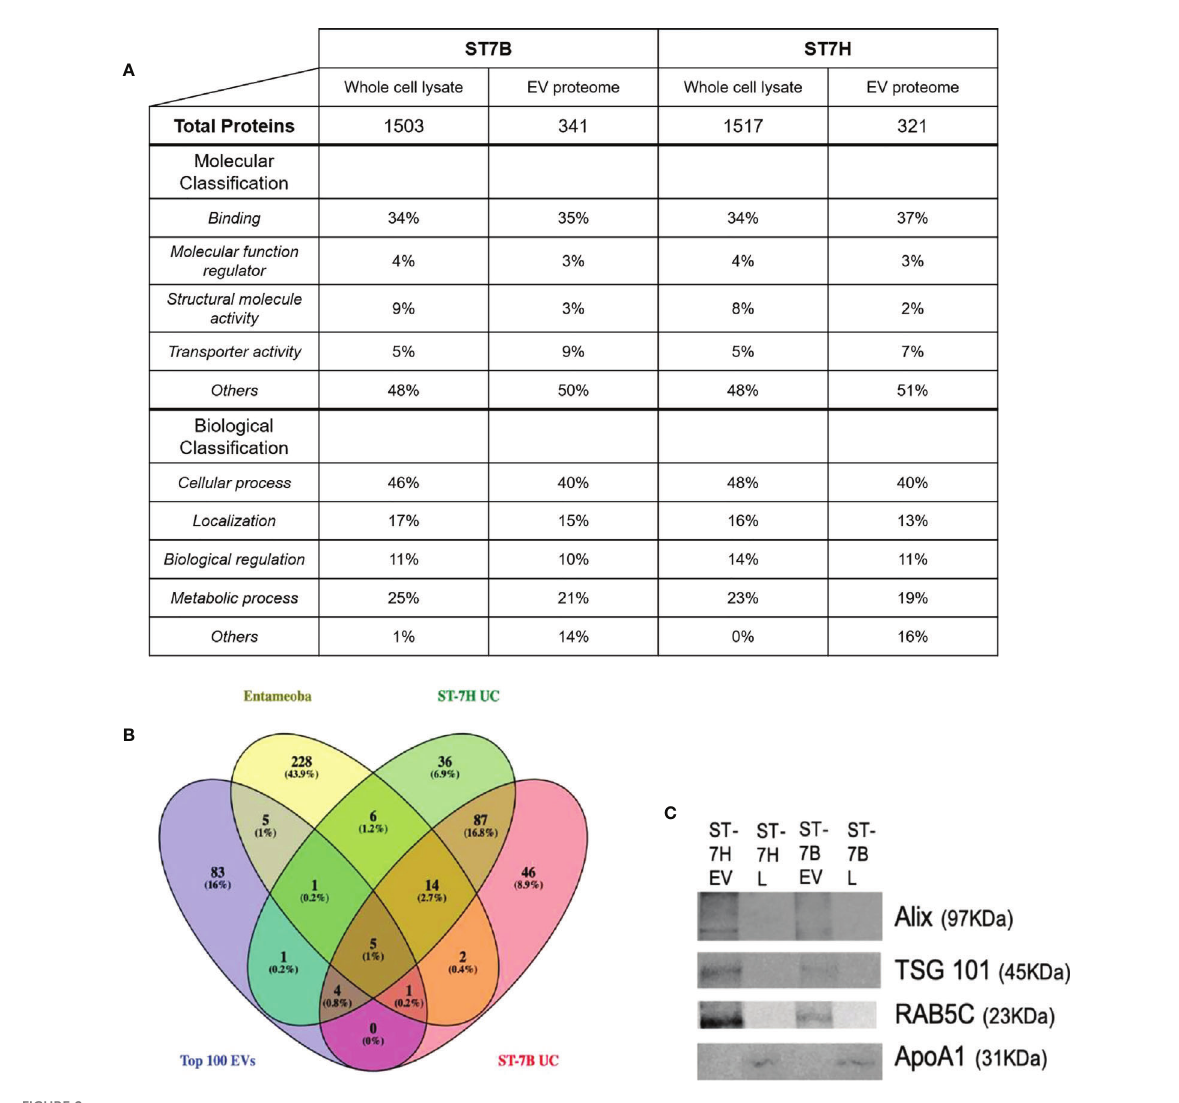
FIGURE 2 Functional analysis of Blastocystis ST7 EV proteome. (A) Table comparing proteins present in ST7 EVs and whole cell lysate. Proteins were identi fi ed using mass spectrophotometry. Protein function predicted using gene ontology analysis via the PANTHER database. (B) Venn diagram showing overlap between ST7B/ST7H EV proteins identi fi ed in this study, Entamoeba histolytica EVs identi fi ed by Sharma et al., 2020, and the top 100 EV markers as curated by the Vesiclepedia database. (C) Western blot analysis of endosomal sorting (RAB5C; 23 KDa), tumour suppressor gene (TSG) 101 (TSG101; 45KDa) and enrichment of vesicle traf fi cking (PDCD6IP/ALIX; 97 KDa) markers in isolated Blastocystis ST7 EVs and lysates (L), with apolipoprotein ApoA1 (31 KDa) serving as negative marker control (Thery et al., 2018). Each lane was loaded with 200 µg EV protein. Western blot shown here is representative of three